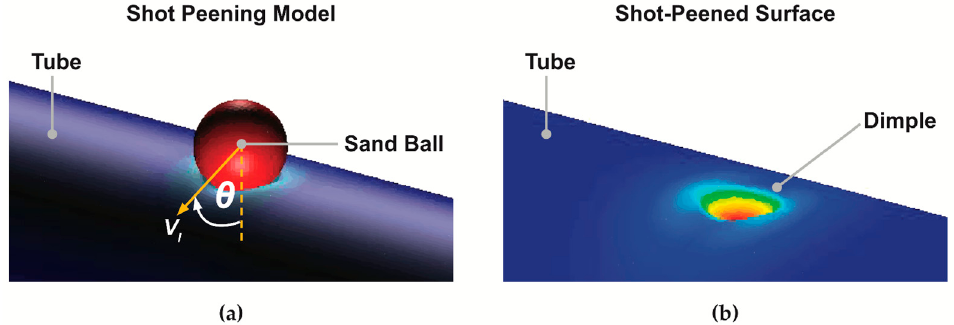
Figure 5. The finite element (FE) simulation of the shot peening on tube surface: ( a ) Shot peening model; ( b ) Shot peened surface.